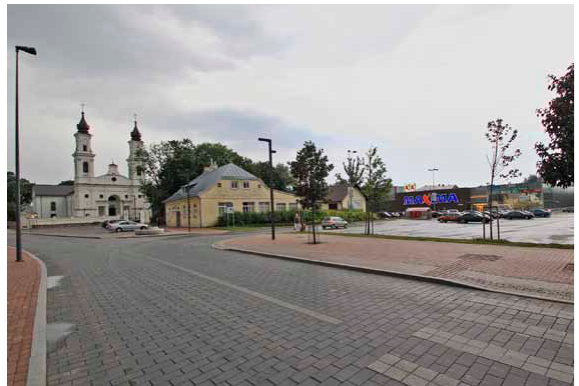
fig. 16. as an unfriendly ‘inclusion’ integrated into an old part of the Marijampolė town, the supermarket “Maxima” has destroyed the street network, the spatial structure and the scale ratio of the territory. E. ramanauskas photo